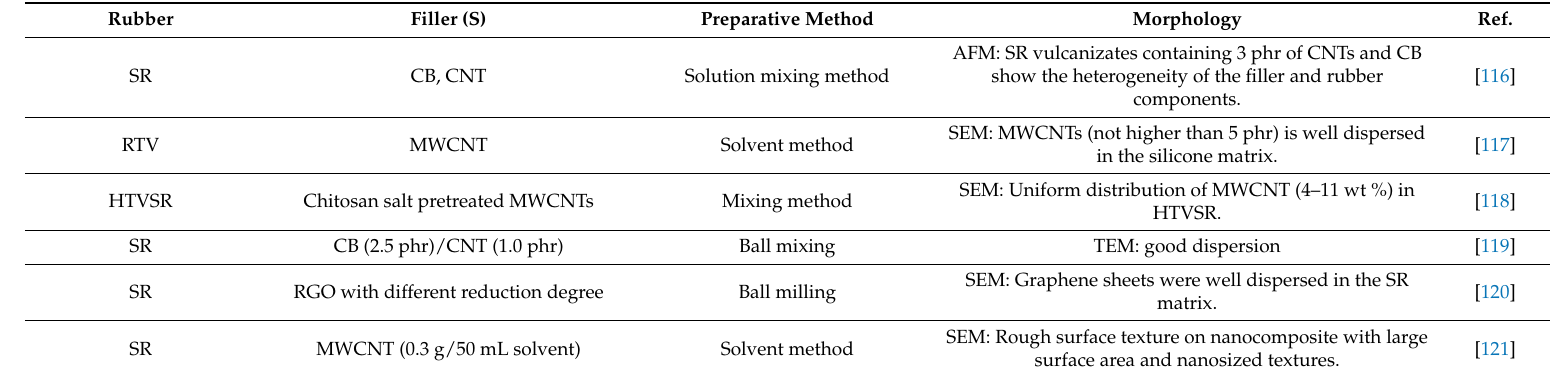
Table 4. Types of carbonaceous nanofillers, preparative methods adopted and morphology of silicone rubber